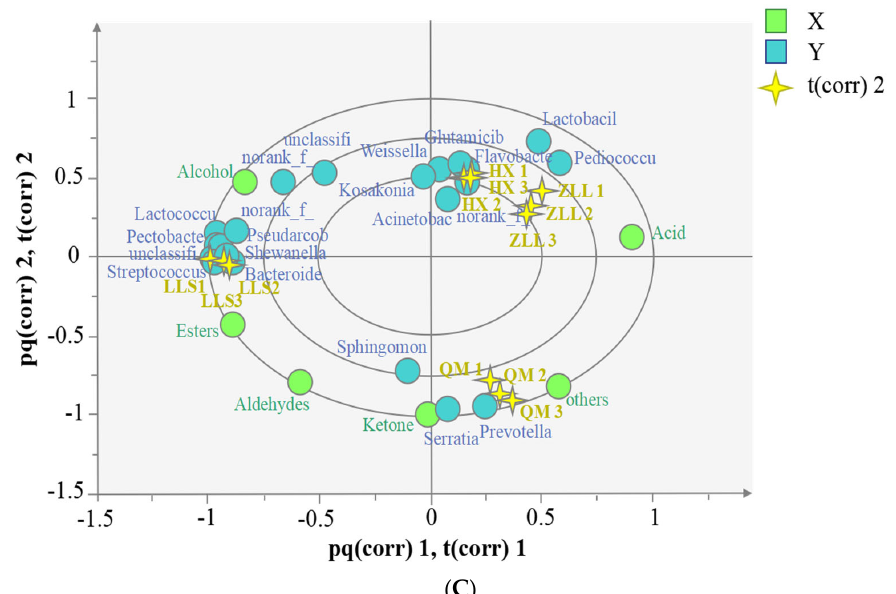
Figure 5. Correlations between bacterial taxa and metabolites. ( A ) O2PLS analysis of amino acids and bacterial taxa, ( B ) O2PLS analysis of organic acids and bacterial taxa, ( C ) O2PLS analysis of VOCs and bacterial taxa.